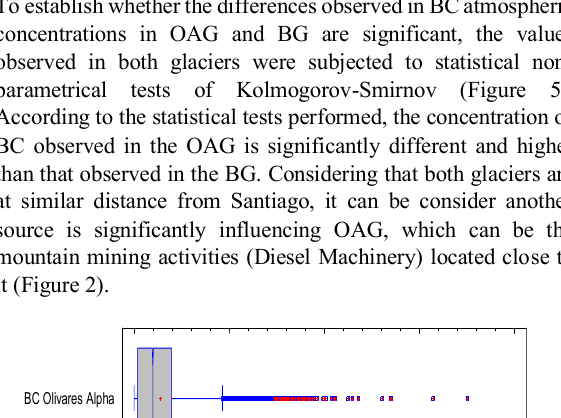
Figure 4. BC atmospheric concentration (blue bars, in ng m -3 ), air temperature (orange line, °C), wind speed (yellow line, m s - 1 ) and wind direction (green line, deg) measured in BG (up) and OAG (down) during the monitoring period.